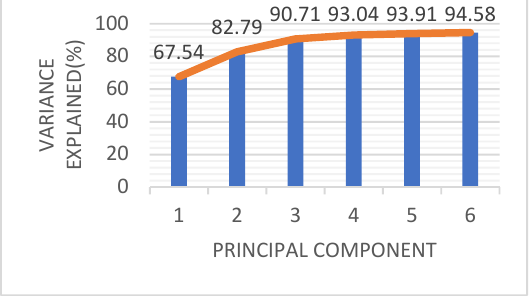
Figure 7. Contribution rates of principal components obtained with PCA feature selection.